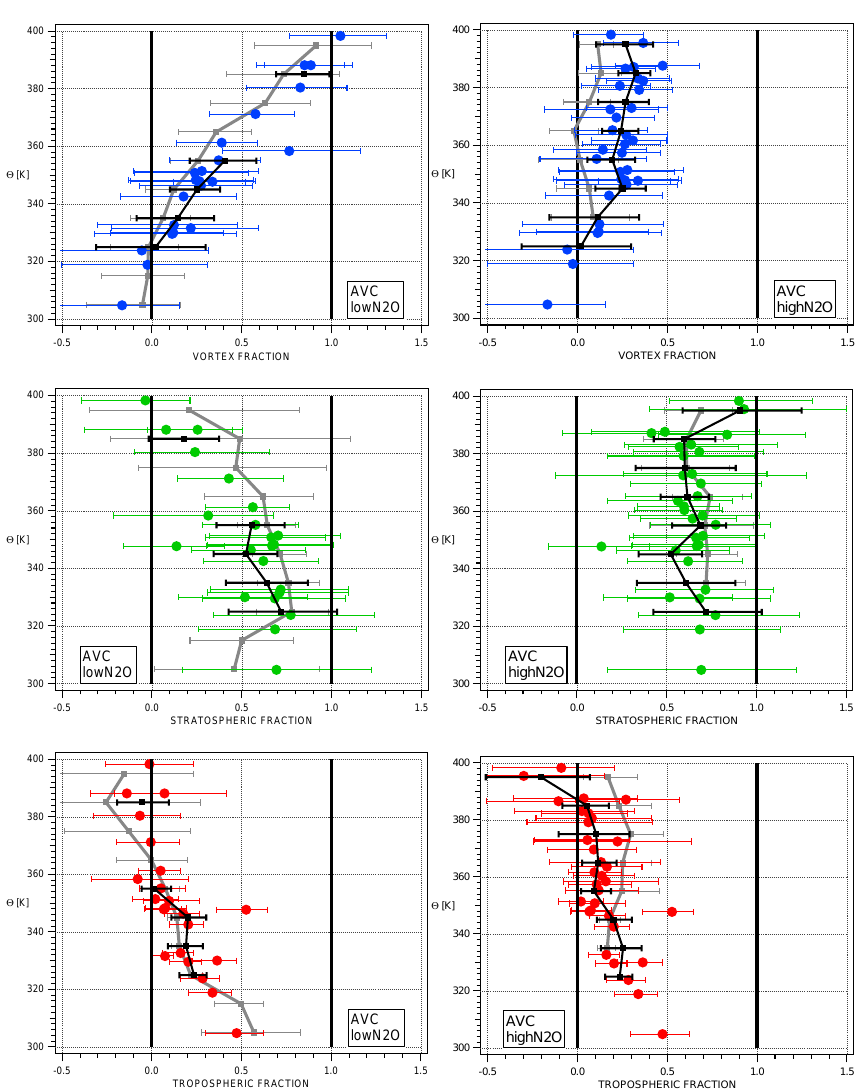
Fig. 9. Same as in Fig. 8, but for the AVC campaign. For intercomparison, the respective average profiles of the EuPLEx campaign have been added in